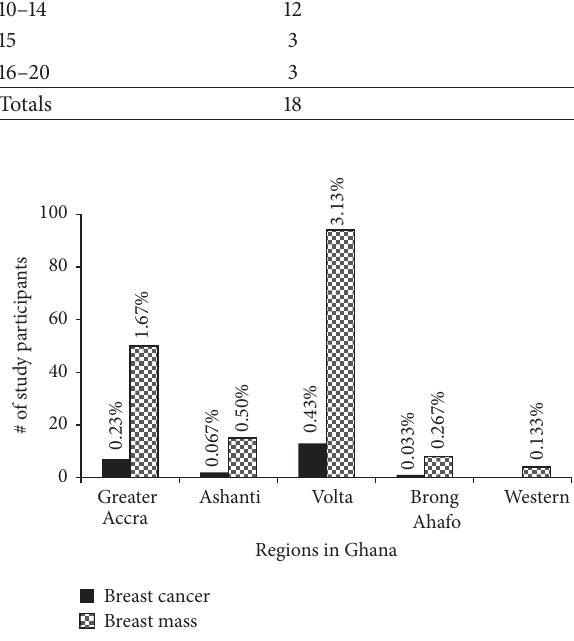
Table 3: Relationship between breast cancer histology and onset of menstruation. Early menarche is an increased risk factor. Menarche